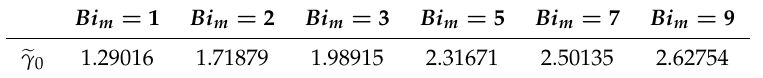
Table 3. Values of (cid:101) γ 0 for R eq / L r = 0.7, α 0 = 0.5, V eq / V 0 = 0.85 and different values of Bi m . Bi m = 1 Bi m = 2 Bi m = 3 Bi m = 5 Bi m = 7 Bi m = 9 (cid:101) γ